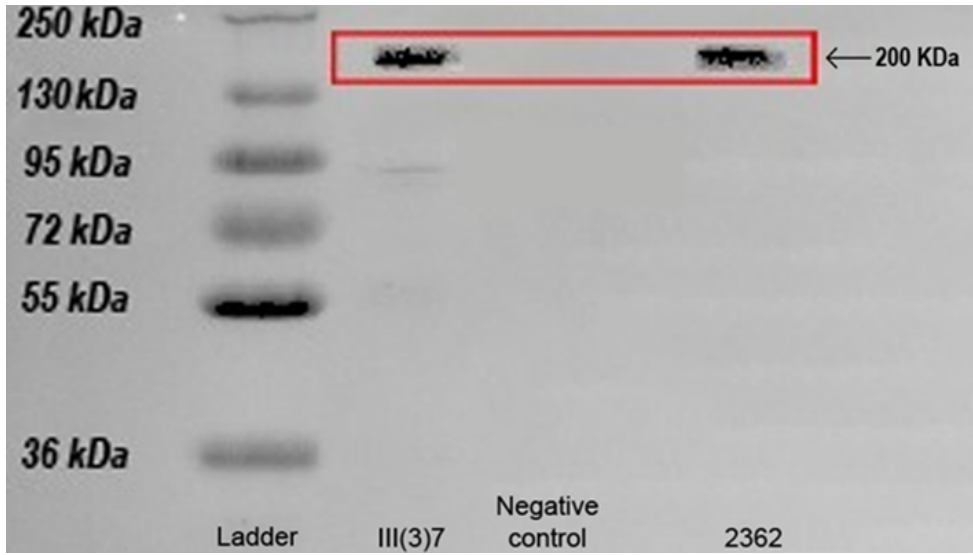
Figure 1. Acrylamide gel for the confirmation of surface layer (S-Layer) protein presence after the extraction protocol. The first lane corresponds to the protein ladder, the second ladder to L. sphaericus III(3)7 S-Layer protein, the third to a negative control treatment (MQ water), the fourth intentionally left empty, and fifth to L. sphaericus 2362 S-Layer protein.